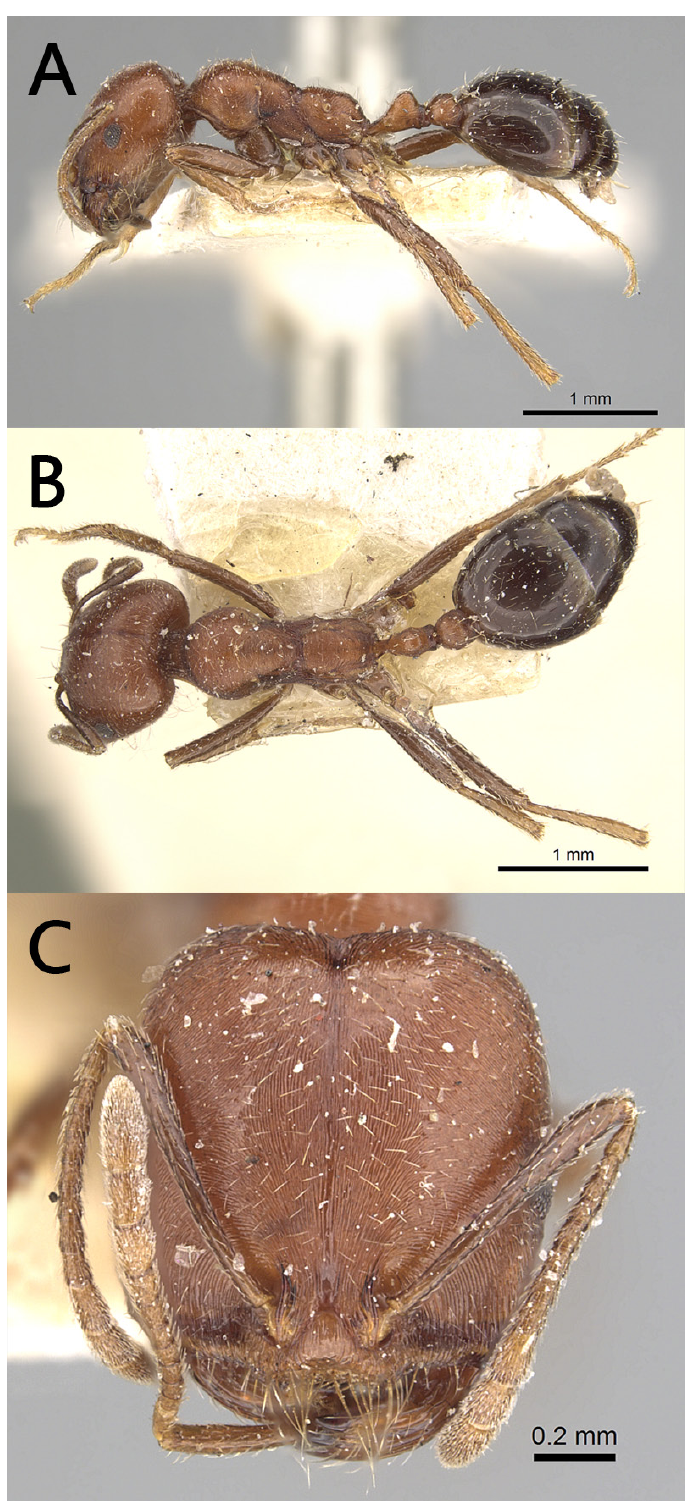
Fig. 9. Trichomyrmex lameerei (Forel, 1902), lectotype, worker (CASENT0249871) . A . Body in profile. B . Body in dorsal view. C . Head in full-face view (photos: Shannon